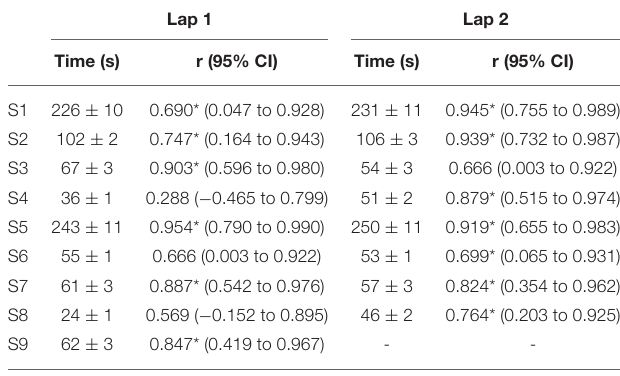
FIGURE 1 | A schematic of the course profile including specific uphill (S1, S3, S5, S7), downhill (S2, S4, S6, S8), and flat (S9) sections.